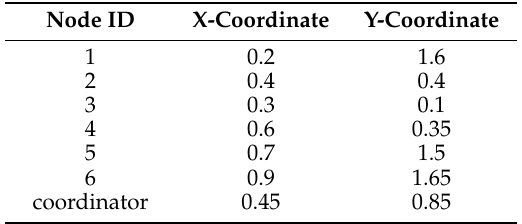
Table 6. The Coordinates of In-Body Nodes and Coordinator.